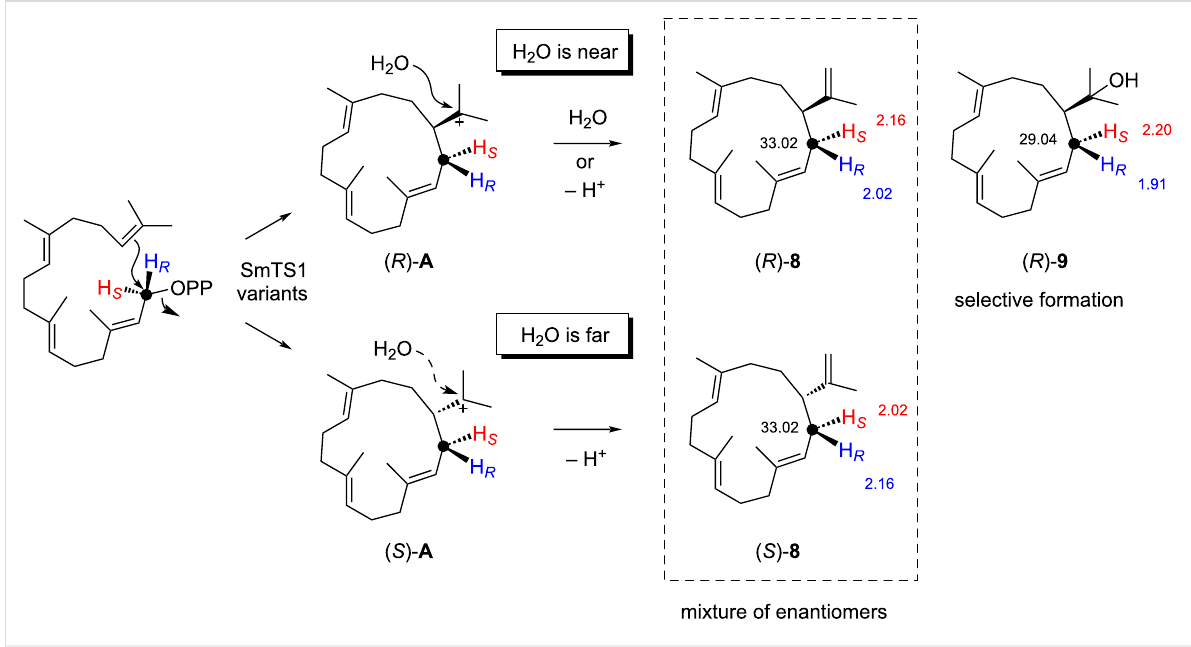
Scheme 1: Determination of the enantiomeric composition of 8 and 9 obtained from GGPP with SmTS1 enzyme variants through enantioselective labelling with ( R )- and ( S )-(1- 13 C,1- 2 H)GGPP. Compound 8 is obtained with different enantiomeric ratios through ( R )- and ( S )- A . Compound 9 may be obtained with a high enantioselectivity, because an active site water could be near to the cationic centre in ( R )- A , but distant in ( S )- A .